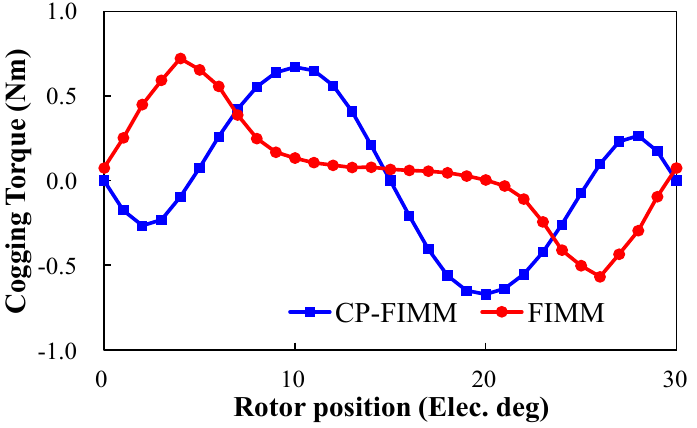
Figure 11. Cogging torque waveforms.